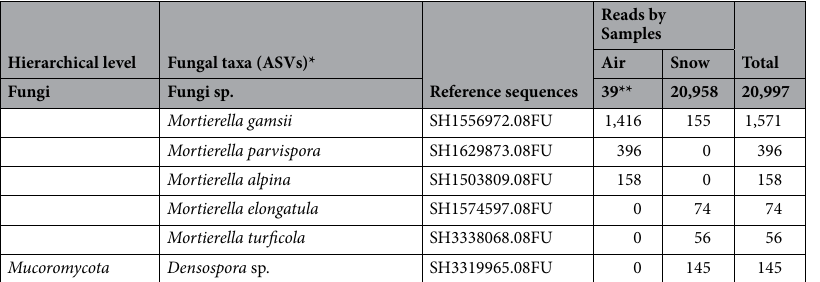
Table 1. Numbers of sequence reads of fungal amplicon sequence variants (ASVs) detected in air and snow samples from Livingston Island, South Shetlands, Antarctica. *ASVs = amplicon sequence variants; **number of the reads.